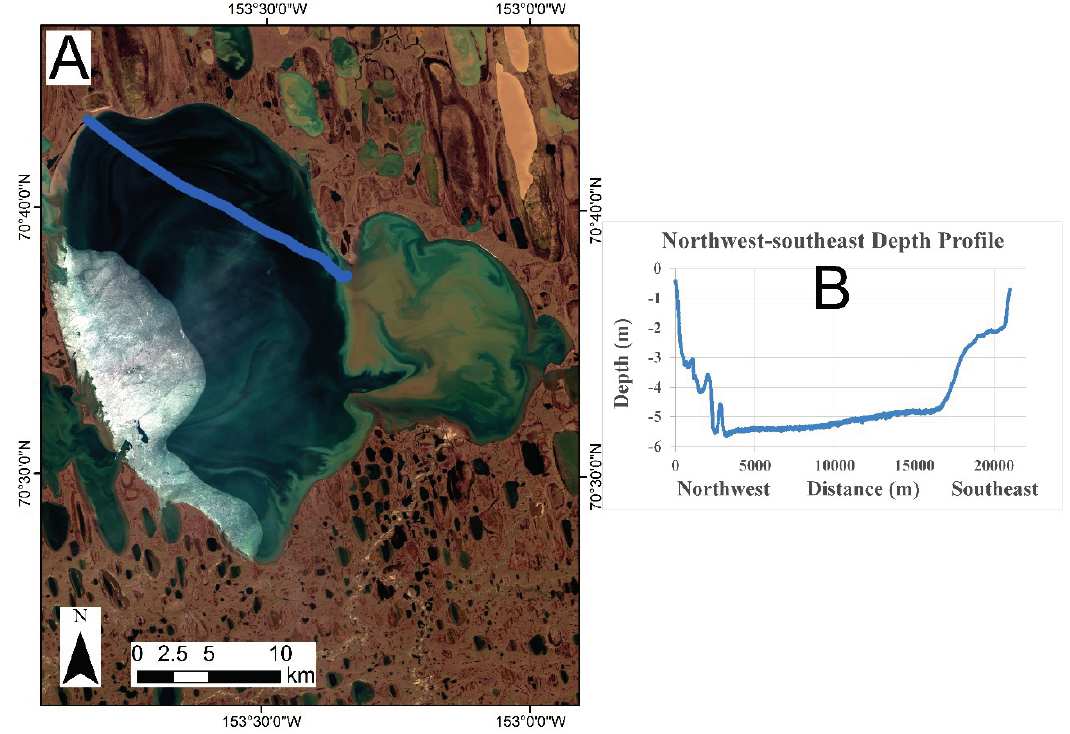
Figure 6. Landsat 8 image of Teshekpuk Lake acquired on 12 July 2013 ( A ). Sonar-based bathymetry profile indicates that it also has a nearly flat lake bottom ( B